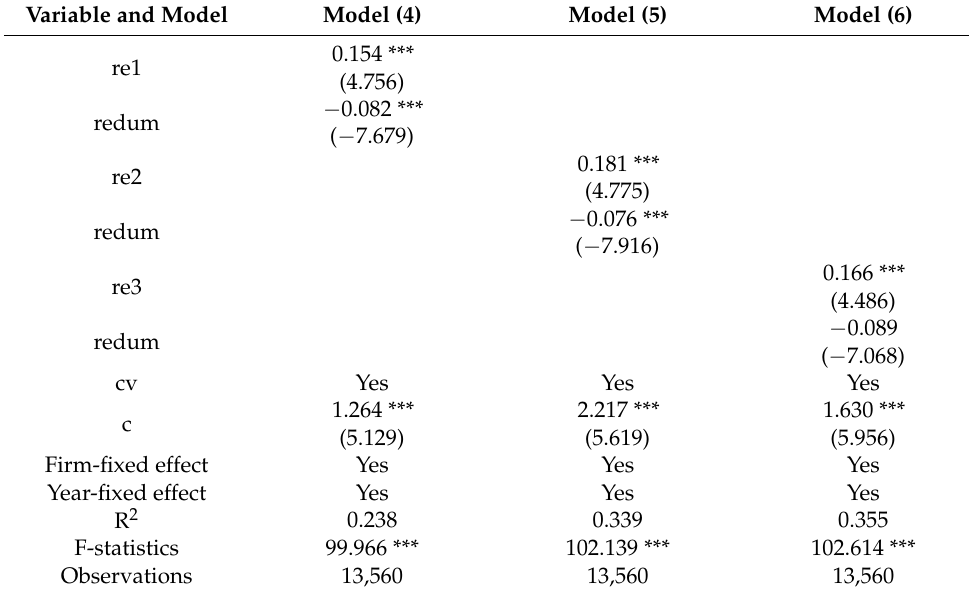
Table 4. Results of heterogeneity analysis.